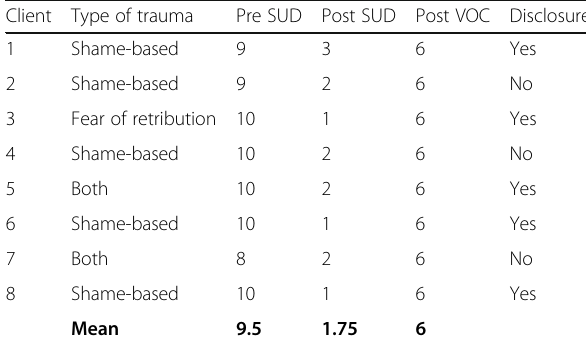
Table 6 EMDR Therapy Blind 2 Therapist [B2T] clinical